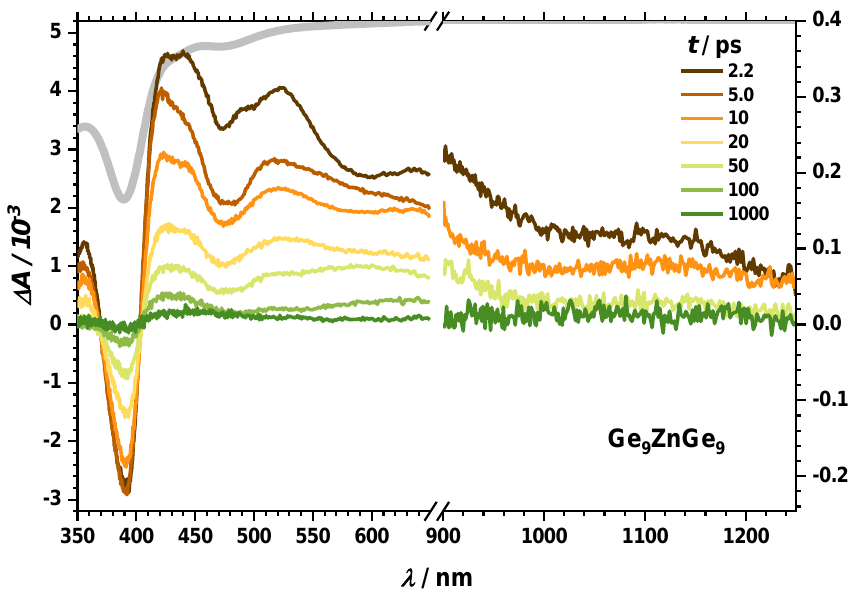
Figure 7. Transient spectra at given delay times for Ge 9 ZnGe 9 in THF after 267 nm excitation. Ground state absorption spectrum in gray is inverted.